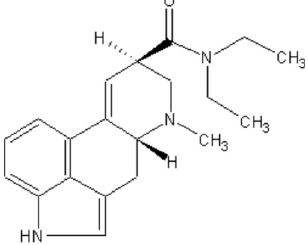
FIGURE 1 - LSD chemical structure (P.M.: 323.432; CAS: